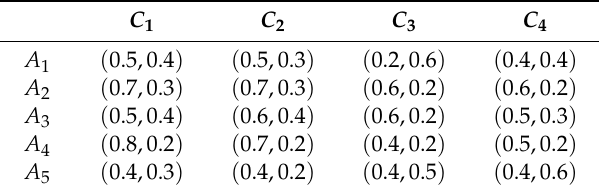
Table 9. The original fuzzy decision matrix A 1 given by D 1.